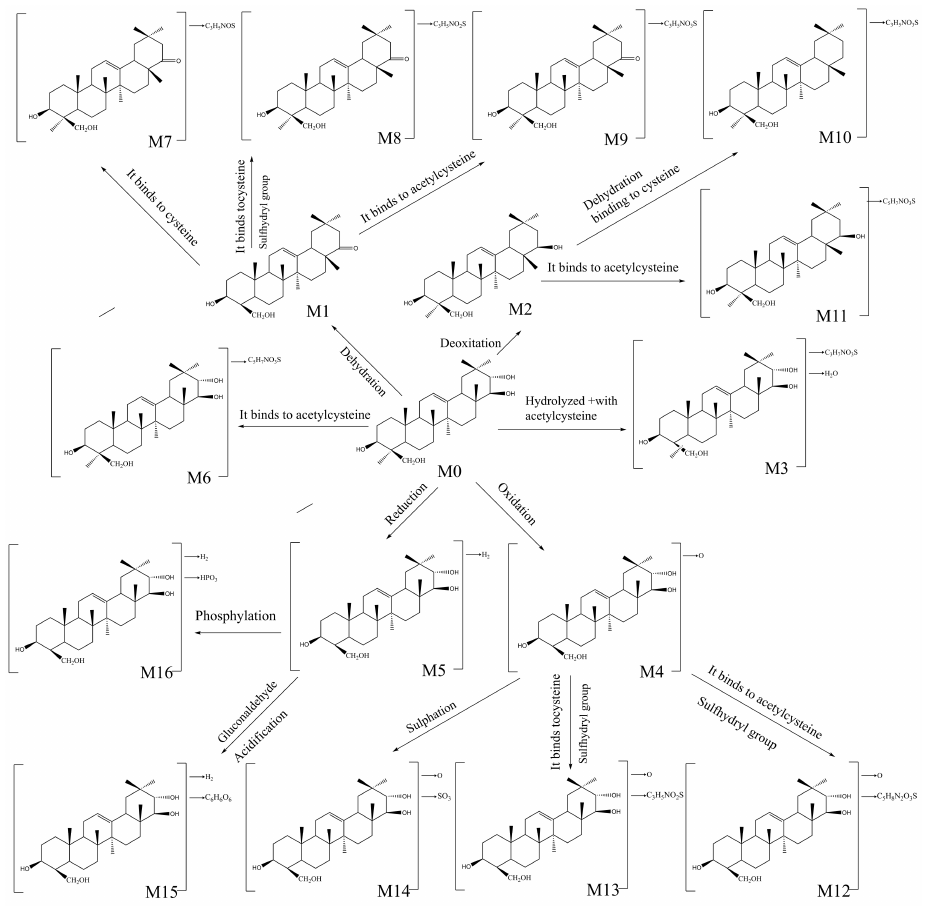
Figure 5. Proposed metabolism of soyasapogenols following oral and intravenous administration in